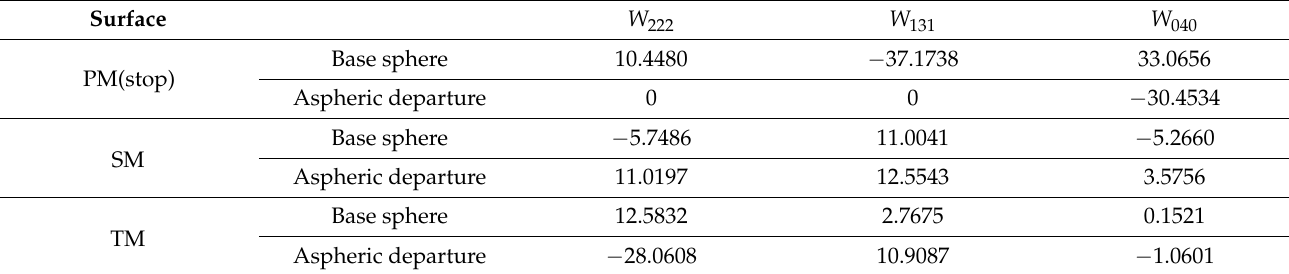
Table A2. Aberration coefficients for each individual surface ( λ = 632.8